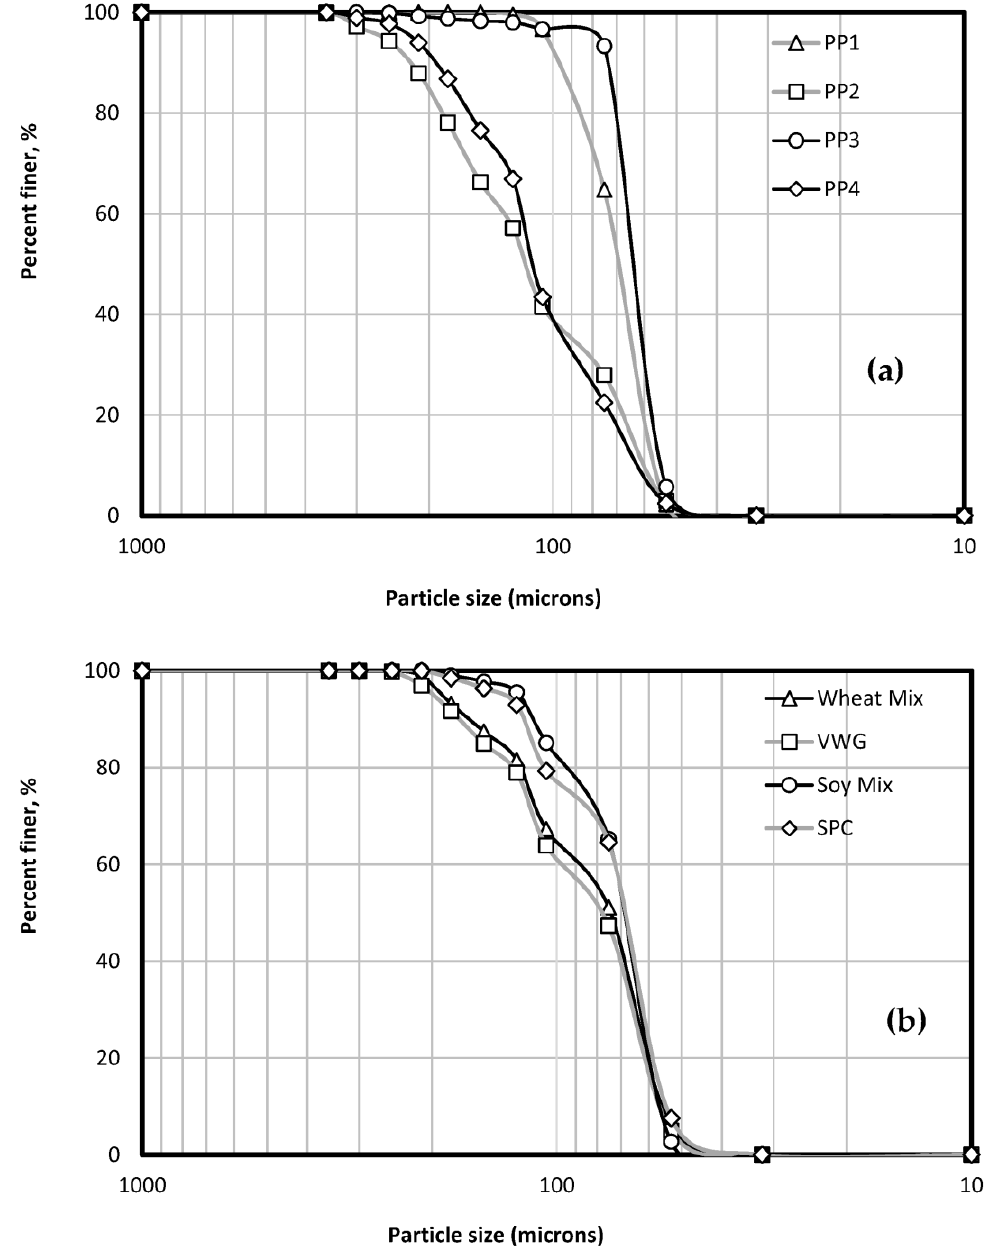
Figure 1. Particle size distribution of ( a ) pea protein and ( b ) wheat and soy treatments as the cumulative percentage of particles that passed through each sieve.